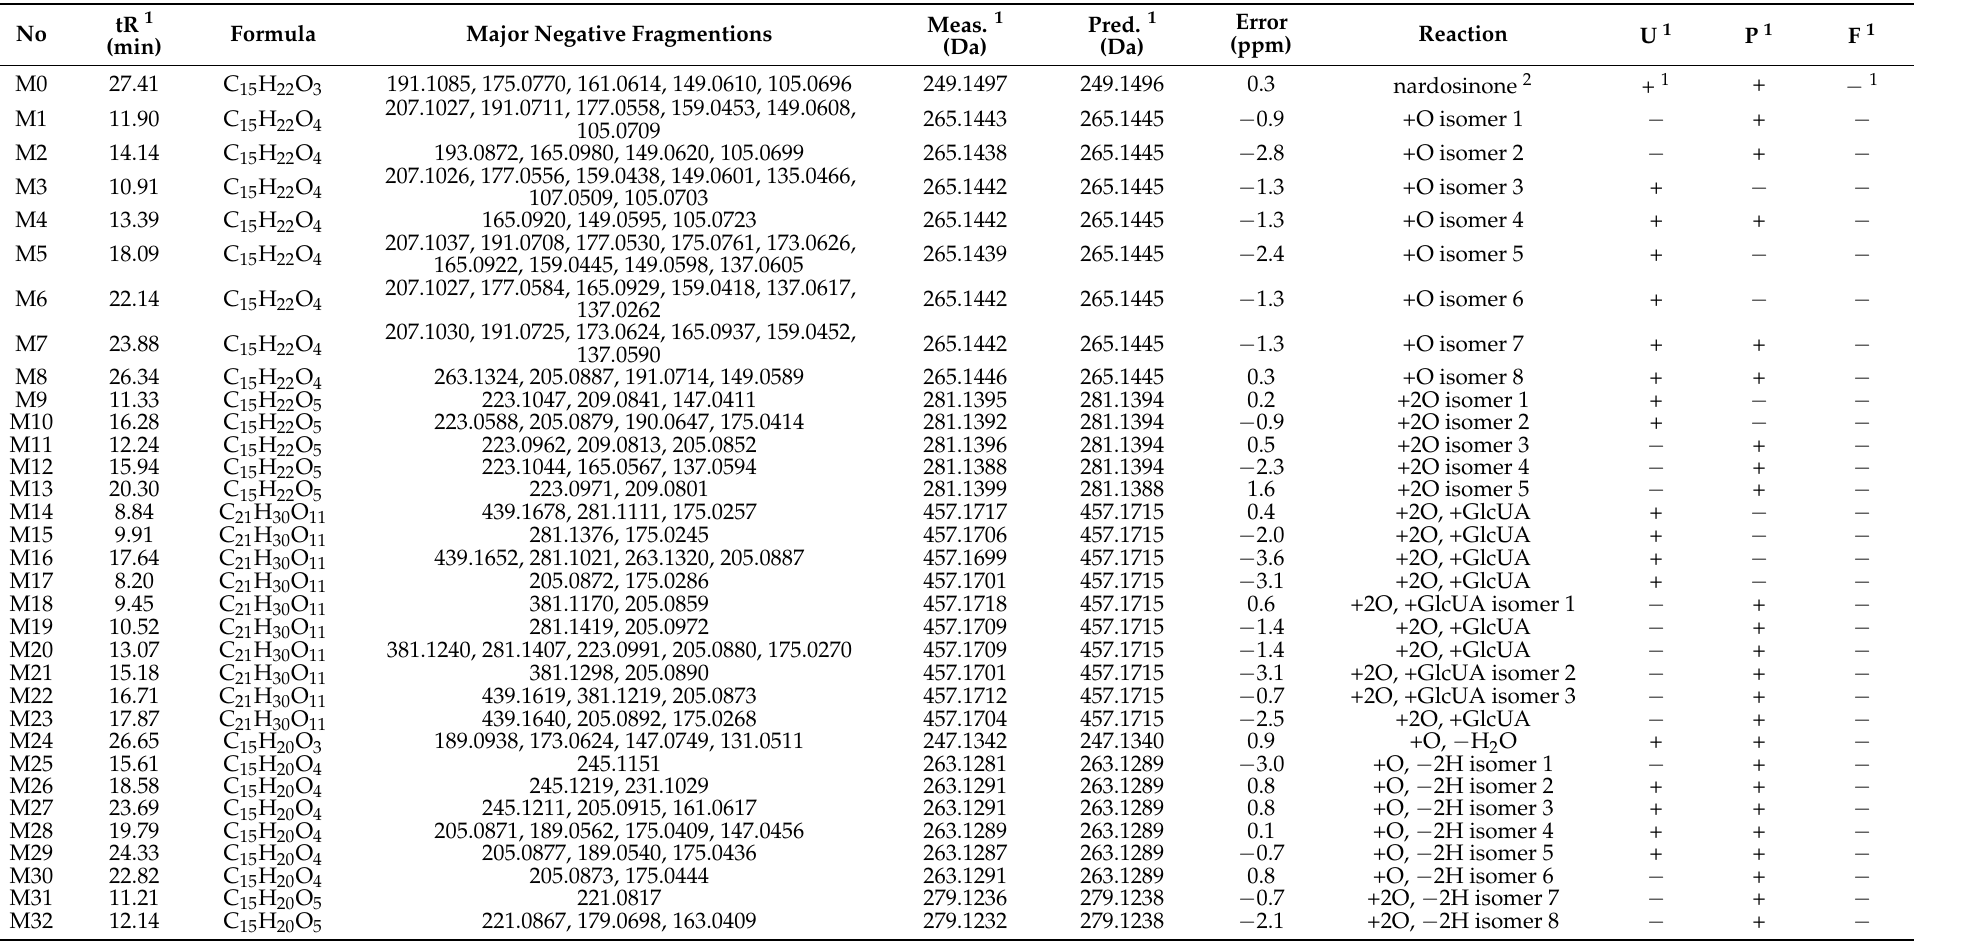
Table 1. Identification of nardosinone and its 76 metabolites in mice urine, feces, and plasma samples by